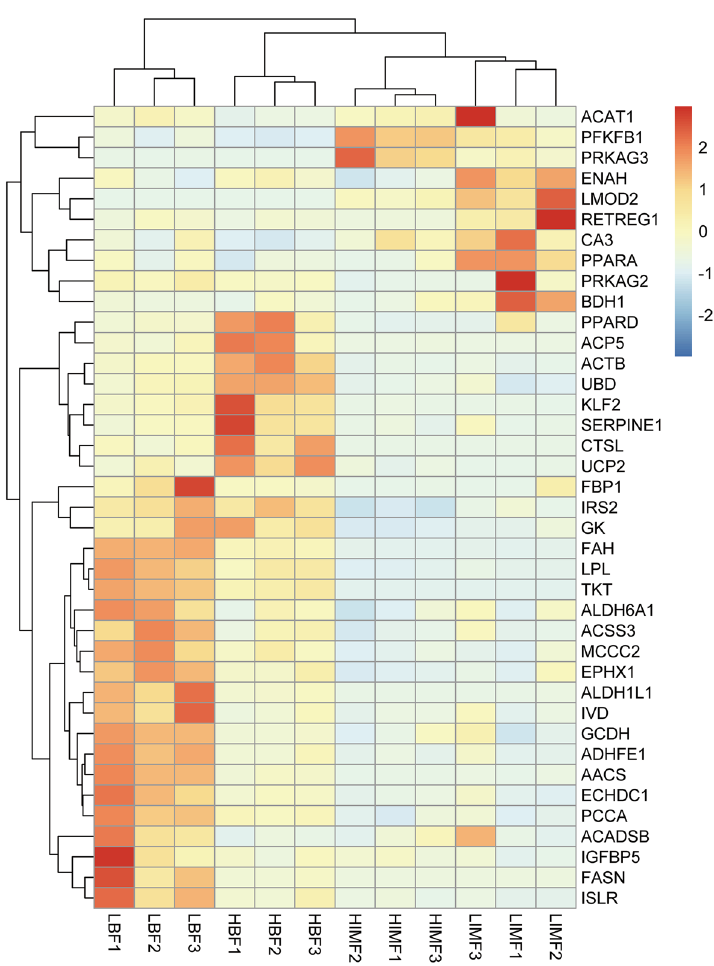
Figure 4. The expression levels of the candidate genes differentially expressed in the four groups of samples. Red colors represent high gene expression, blue colors represent low gene expression, and the color intensity changes with the FPKM